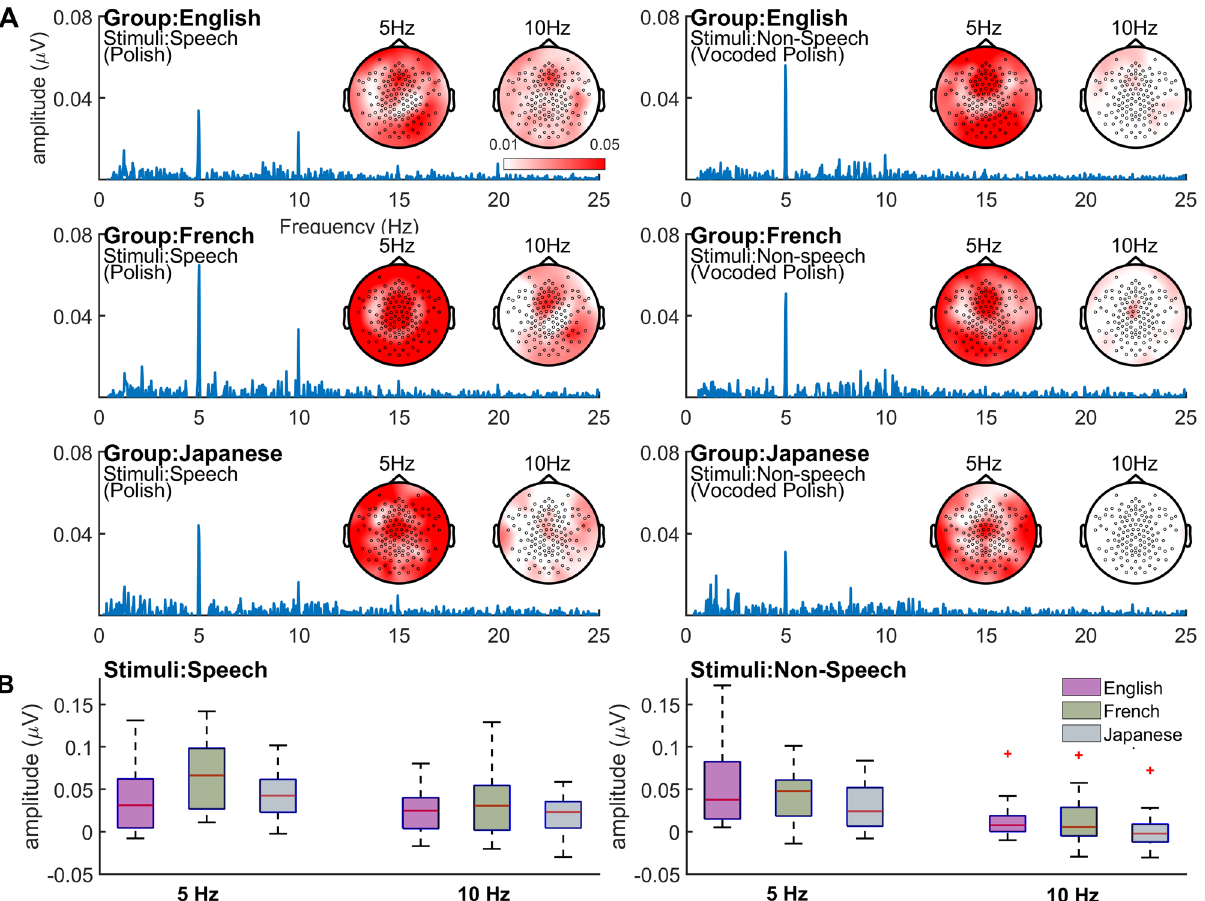
Figure 4. ( A ) Spectrogram and topography of responses for Speech (Polish) and non-speech (Vocoded Polish) stimuli across the three groups—English, French and Japanese language adults. ( B ) Response amplitude at 5 Hz and 10